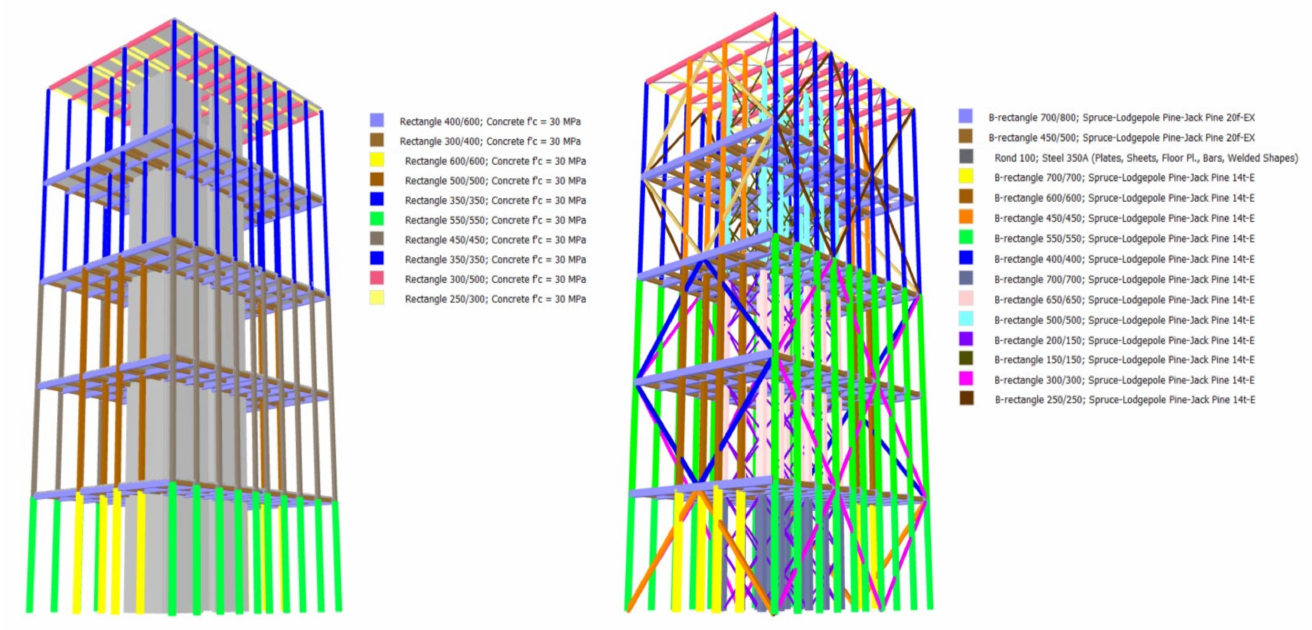
Figure 5. Hyperstructure’s cross-sections: concrete ( left ) and glulam ( right